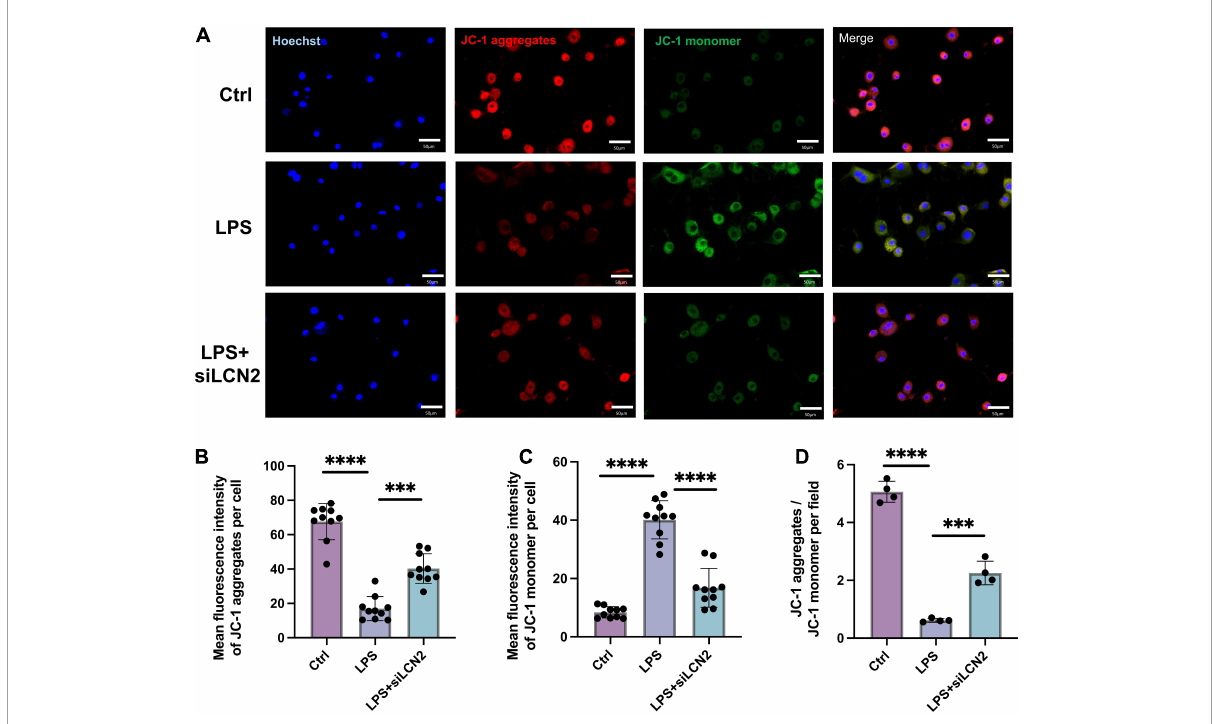
FIGURE6 Silence of LCN-2 restored the mitochondrial membrane potential damaged by LPS. (A) Mitochondrial membrane potential (JC-1) of LPS damaged H9C2 cardiomyocytes pretreated with siLCN2. Red indicated JC-1 aggregates and green indicated JC-1 monomer ( n = 3, scale bar = 50 µ m). (B–D) Quantitative results of mitochondrial membrane potential. Data are presented as mean ± SEM. Statistical analysis was via one-way ANOVA with Bonferroni multiple-comparison correction; ∗∗ P < 0.01, ∗∗∗ P < 0.001, and ∗∗∗∗ P < 0.0001.